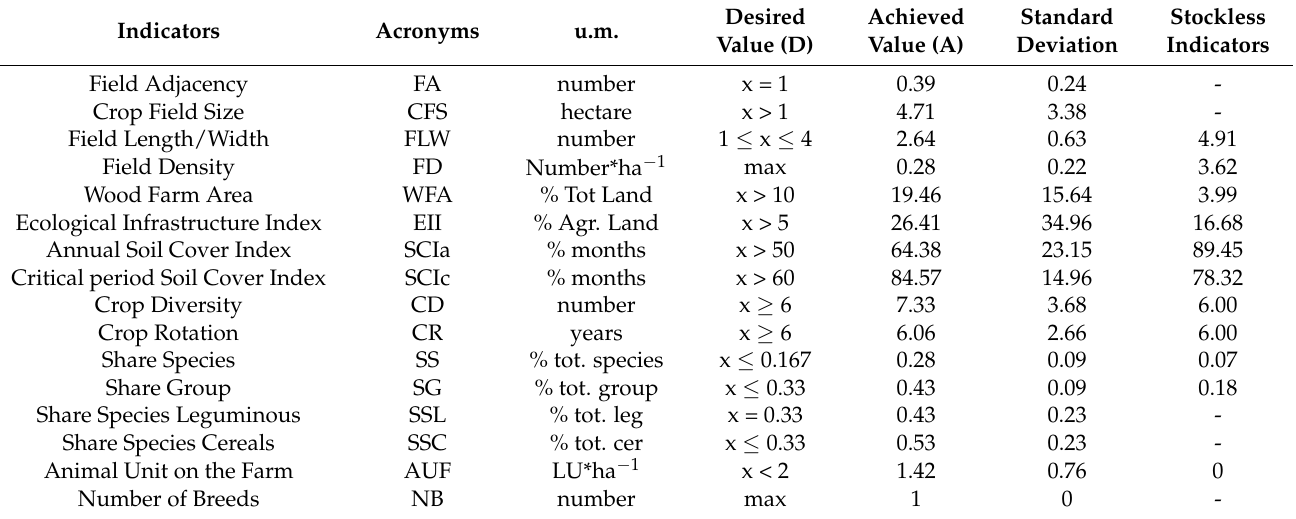
Table 4. List of agroecological indicators, acronyms, optimal value, achieved value and standard deviation from the average of 12 case